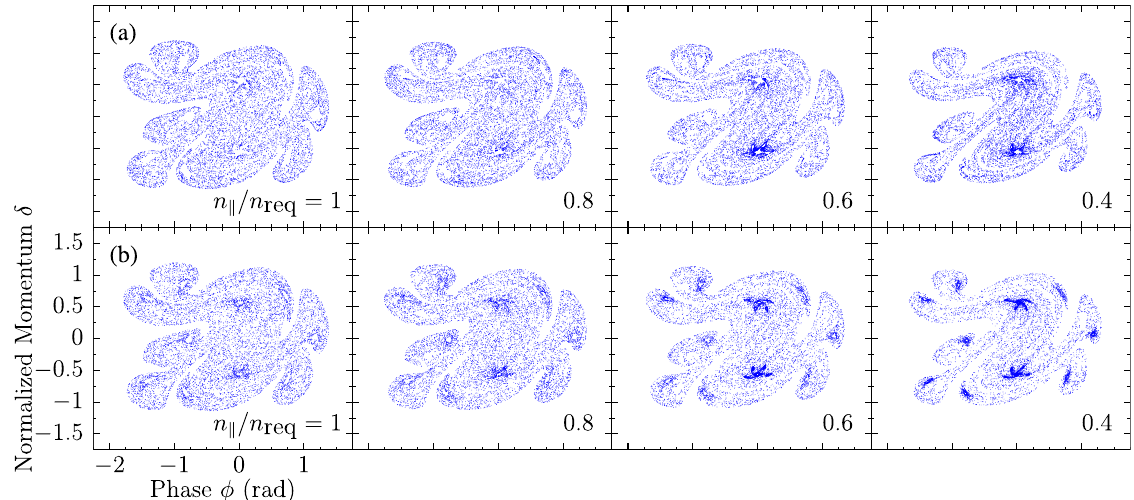
¼ 28 °, Δ ϕ ¼ 45 °, ν ¼ 2 ν , rh ¼ 1 , and radiation damping considered as opposed to m o m s ¼ 100 ; 000 revolutions with the columns n ¼ 1 , 0.8, 0.6, and 0.4, respectively. As ∥ =n req req